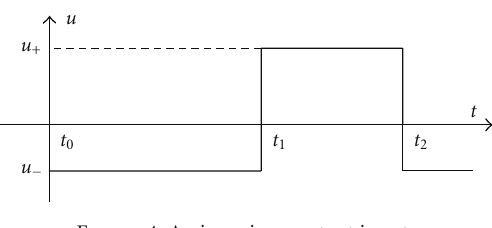
Figure 4: A piecewise constant